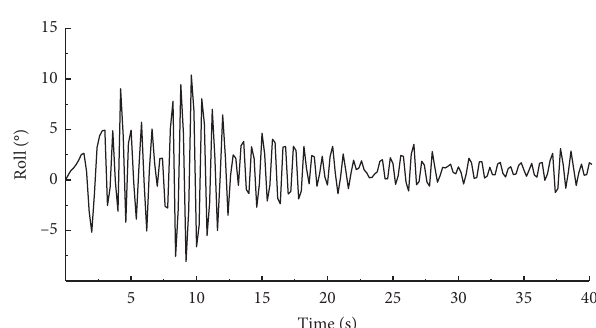
Figure 8: Time series of ship roll motion when moored at position I with bow and stern